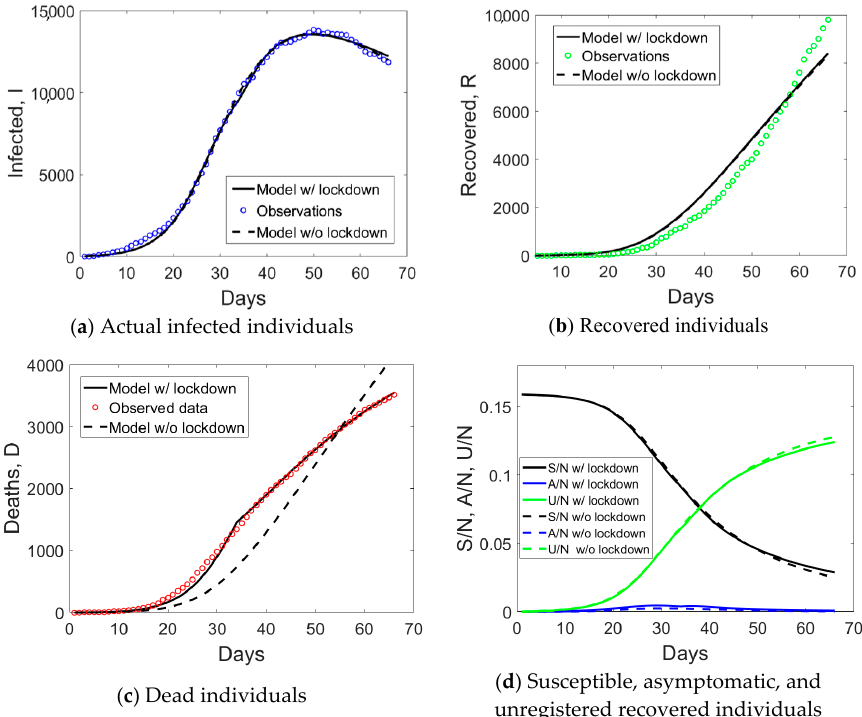
Figure 8. Simulated compartments including or excluding lockdown measures in the model, with time-dependent or time-indepedent parameters, for Emilia Romagna.